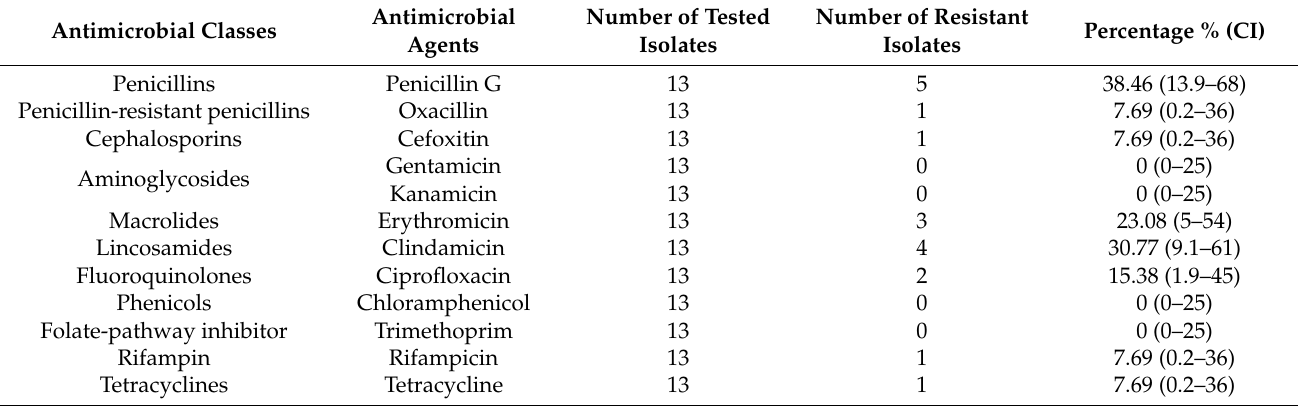
Table 4. Antimicrobial resistance among 13 S. aureus (including MRSA) from meat and meat products in selected KZN province